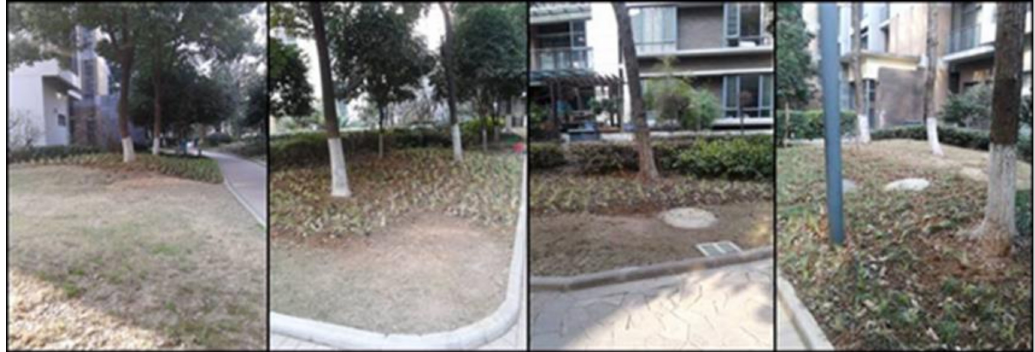
Figure 8. Planting areas for Zoysia matrella (L.) Merr., which was replaced with Ophiopogon bodinieri Levl.